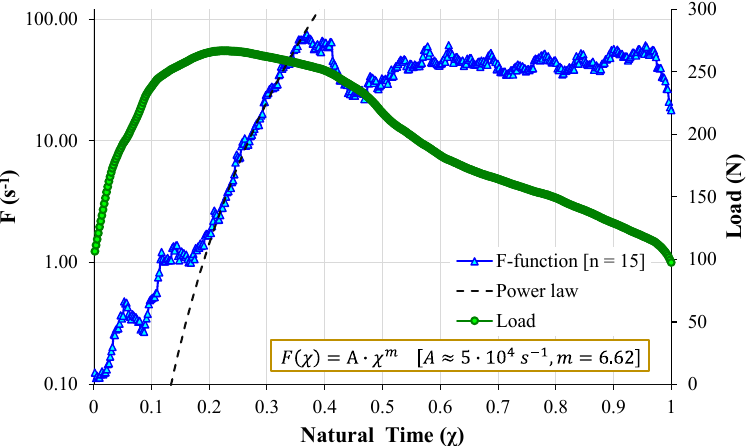
Figure 10. The evolution in the Natural Time domain of the F -function and of the load imposed for the CSR marble specimen.